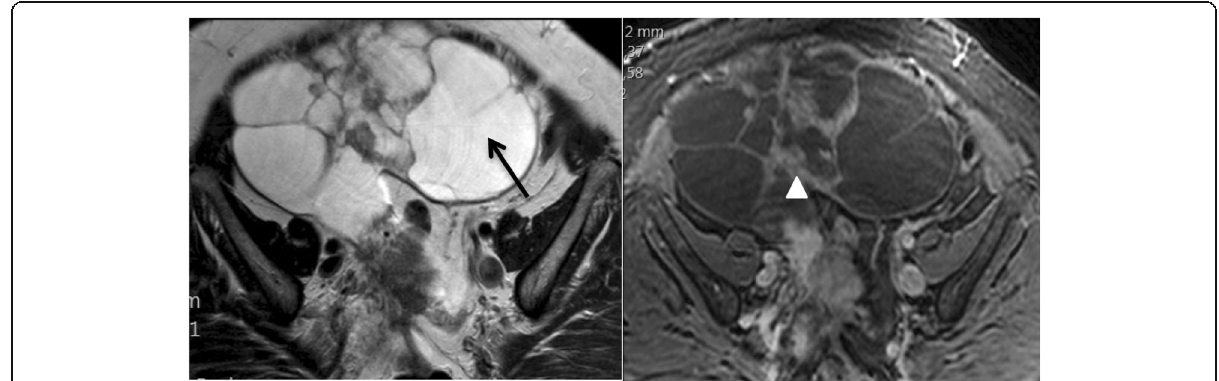
Fig. 5 MRI T2-weighted (left) and T1-weighted fat sat post-contrast (right) images showing a heterogeneously enhancing solid mass with cystic changes (arrow) and papillary projections (arrowhead), corresponding to the primary HGSC of a BRCA mutated patient